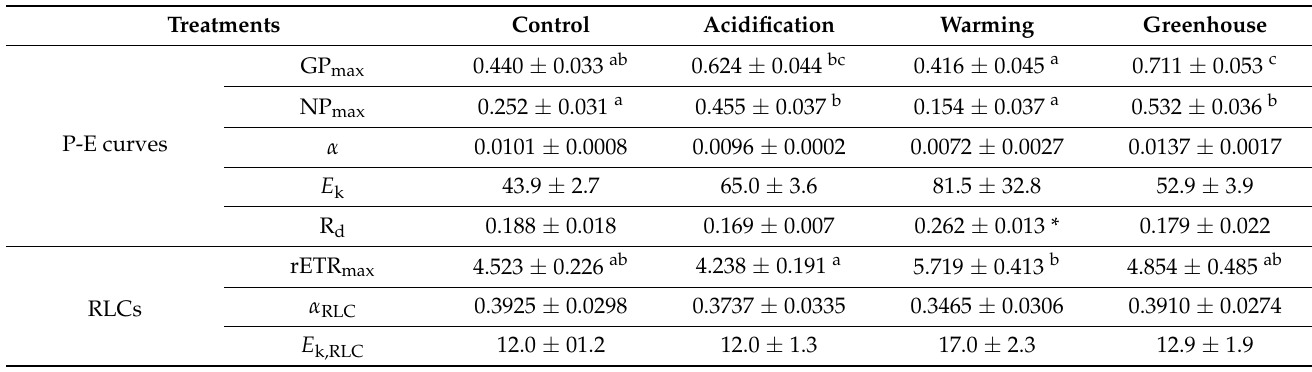
Figure 2. Relative electron transport rate (rETR) of Caulerpa sertularioides after exposure to present and three simulated future ocean conditions for 15 days. Data are represented as mean ± SE (n = 4). Table 2. Photosynthetic parameters of Caulerpa sertularioides from oxygen measurement (P-E curves) and chlorophyll-a fluorescence measurement (RLCs: rapid light curves) after 15 days under present and three future ocean conditions.